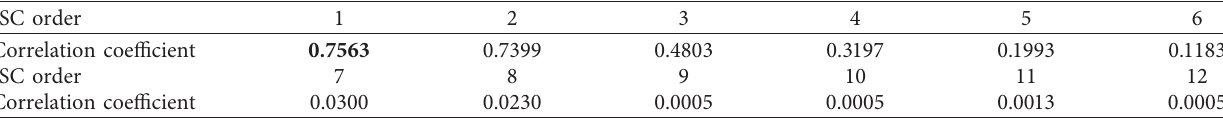
Table 5: Correlation coefficient of ISCs of each order under inner race fault